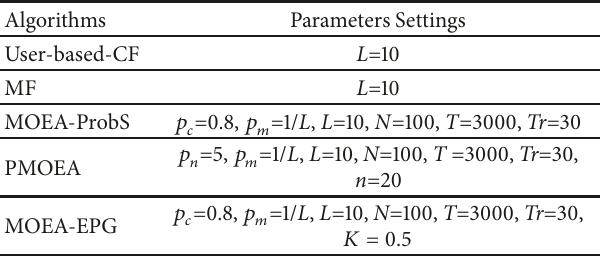
Table 3: The related parameters in comparison